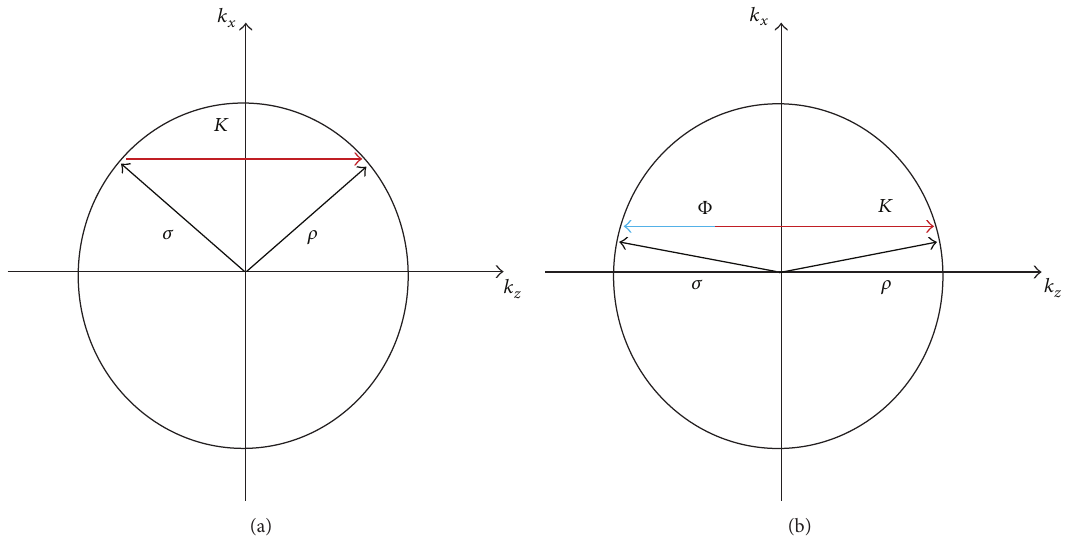
Figure 2: Reconstruction of a reflection diffraction grating (parameters of the 𝛽 value model):(a) at Bragg; (b) out of Bragg.